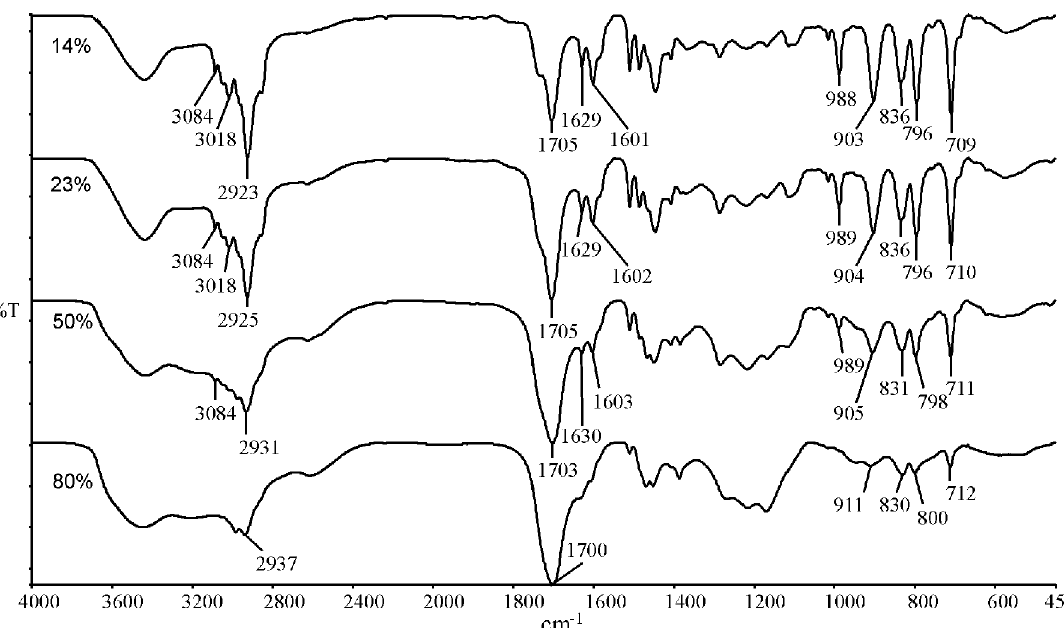
Figure 4. FTIR spectra of polymer particles with acetonitrile/toluene volumetric ratio of 75/25, using top-down: 14%, 23%, 50%, and 80% methacrylic acid molar